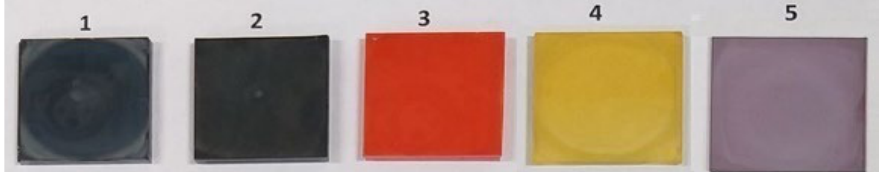
Figure 3. Optical images of the perovskite active layers with various compositions deposited on TiO 2 -coated glass.